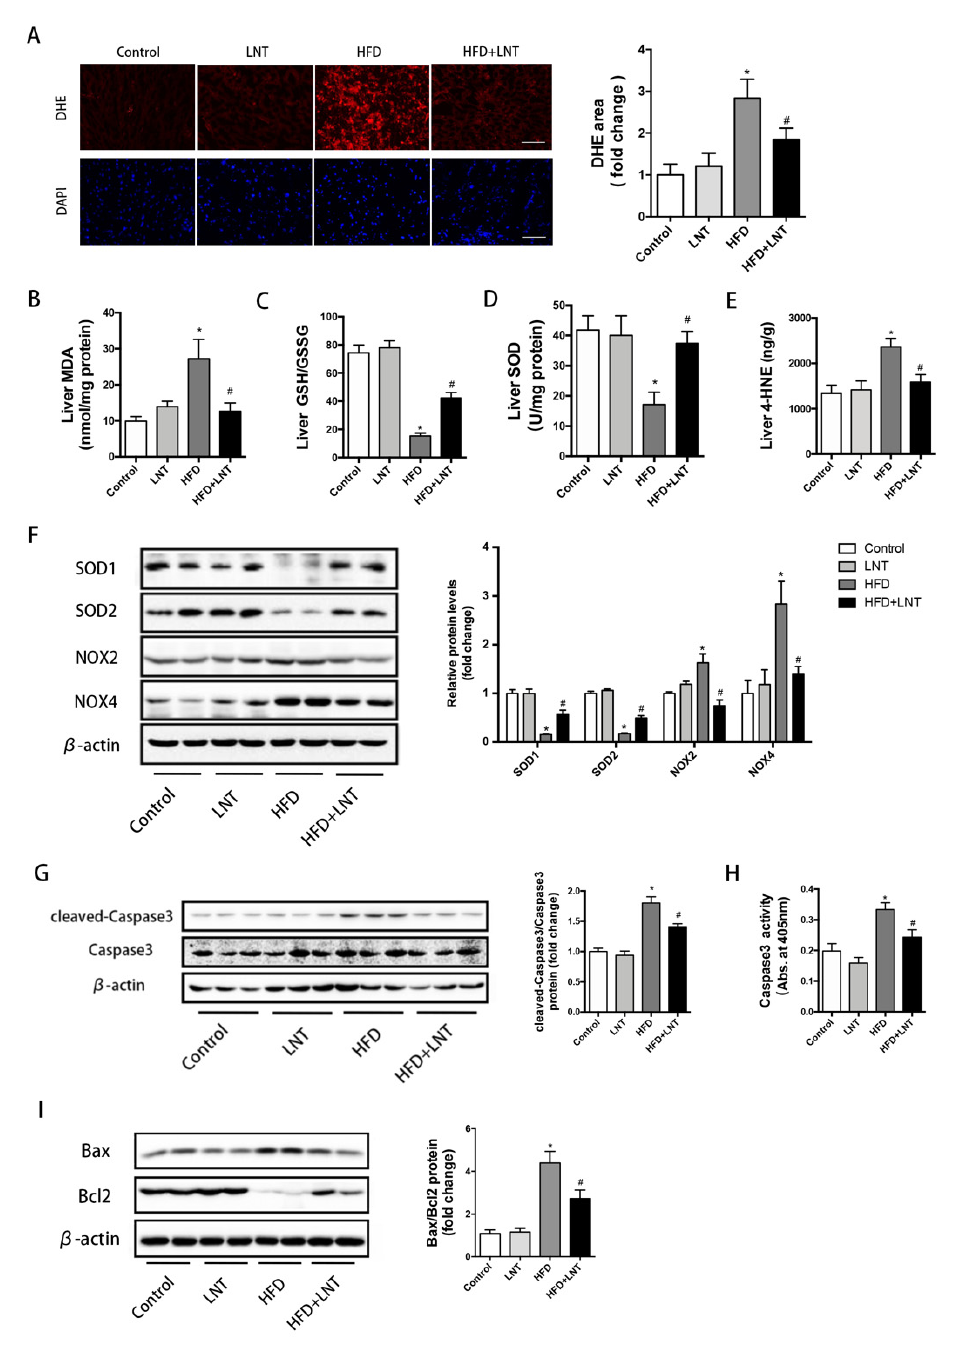
Figure 2. LNT suppressed HFD-induced oxidative stress and apoptosis in the liver. ( A ) Representa- tive images and quantification of DHE staining of hepatic ROS production. ( B – E ) MDA, GSH/GSSH, SOD, and 4-HNE levels in the liver. ( F ) Representative Western blots and quantification of SOD1, SOD2, NOX2, and NOX4 in the liver. ( G ) Cleaved-Caspase3 expression by Western blot analysis. ( H ) Caspase3 activity in livers from the four treatment groups. ( I ) Representative Western blots and quantification for apoptosis-related proteins in the liver. Data are presented as the mean ± SEM ( n = 8 per group). * p < 0.05 compared with the Control group. # p < 0.05 compared with the HFD group.